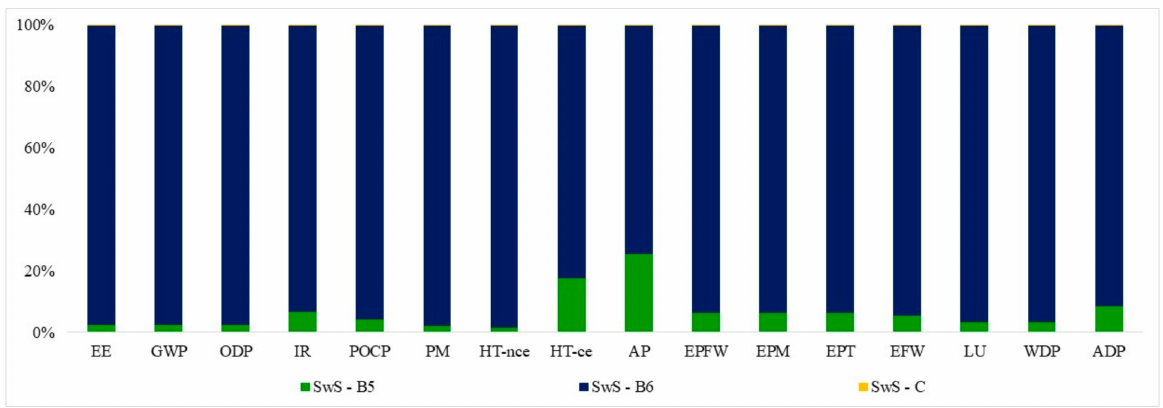
Figure 7. Contribution of the different phases to the life cycle impacts—SwS